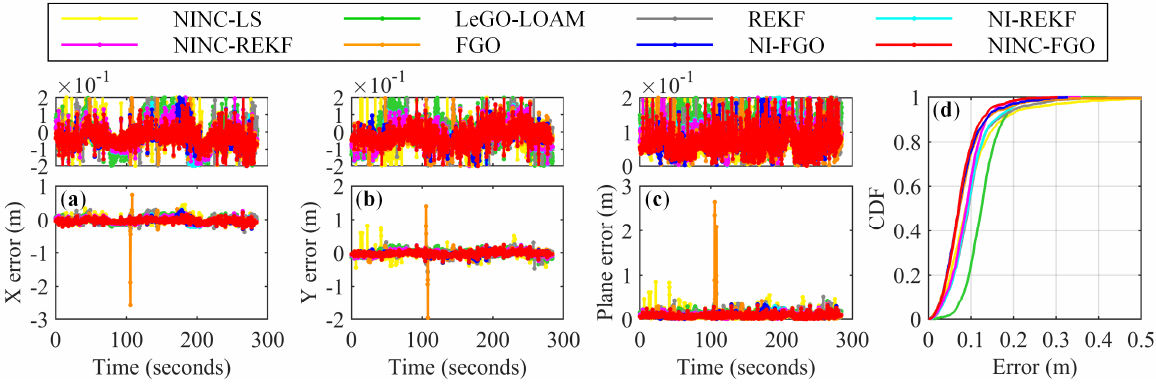
Figure 14. Positioning errors of the NINC-LS (yellow), LeGO-LOAM (green), REKF (grey), NI-REKF (cyan), NINC-REKF (magenta), FGO (orange), NI-FGO (blue) and NINC-FGO (red) methods: ( a ) X direction, ( b ) Y direction, ( c ) plane direction, and ( d ) CDF of the positioning errors. Table 4. Accuracy evaluation of the NINC-LS, LeGO-LOAM, REKF, NI-REKF, NINC-REKF, FGO, NI-FGO and NINC-FGO methods.